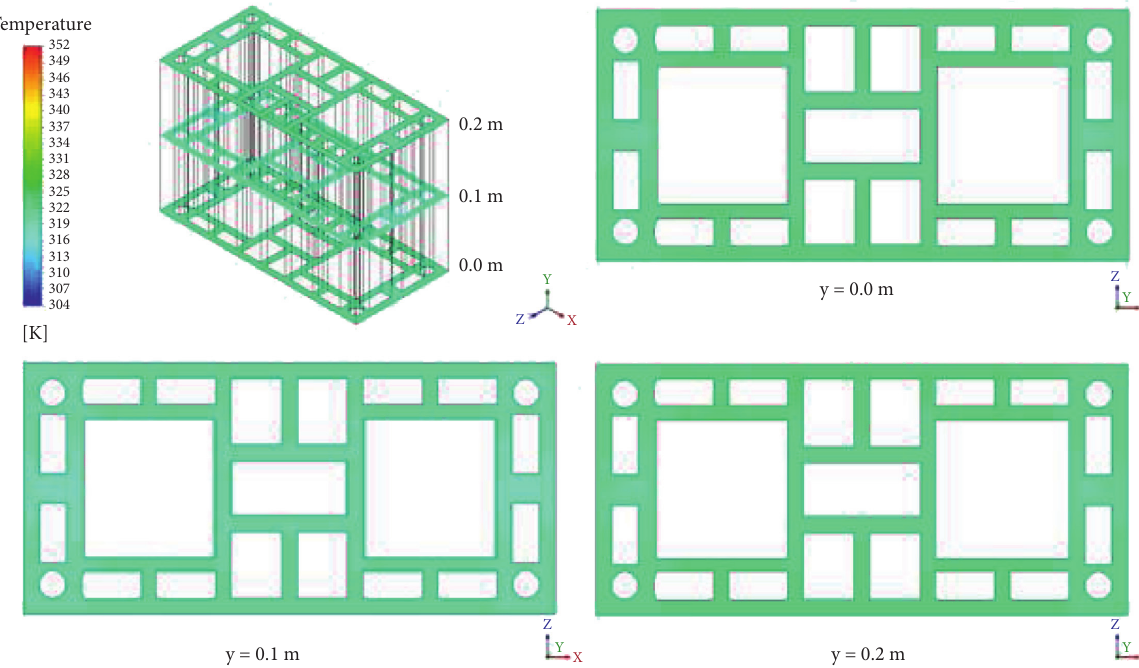
Figure 12: Temperature field inside the brick at different XZ planes, with the elapsed time of 60 minutes ( T � 80 ° C, RH � 5%). Temperature